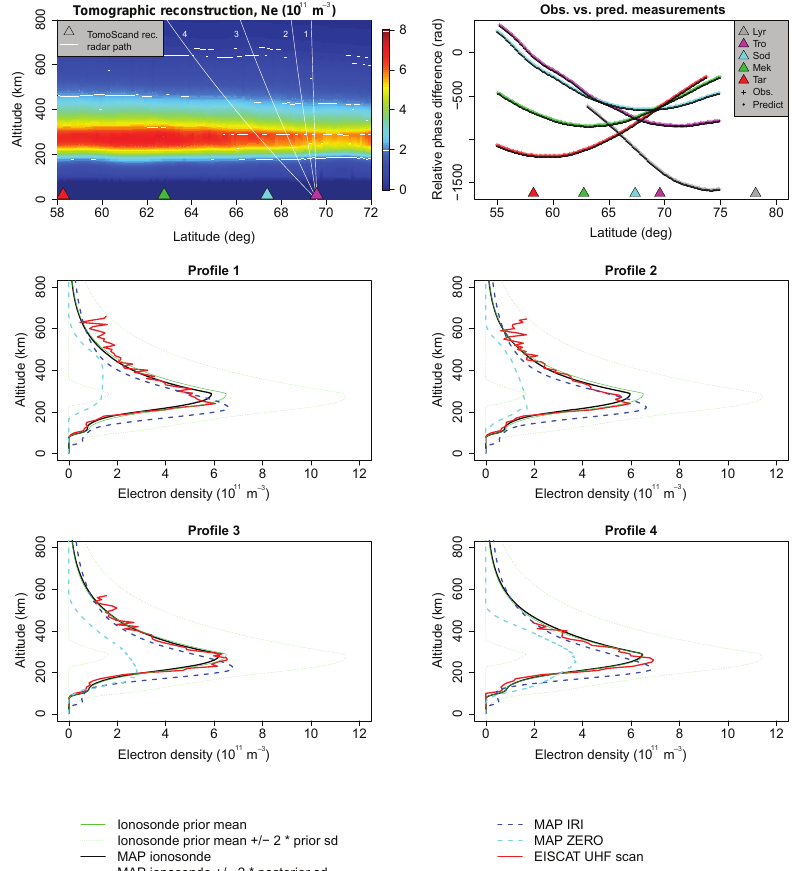
Figure 6. Reconstruction, phase curves and profile comparisons for Overflight III starting on 14 November 2015 at 13:20UTC.